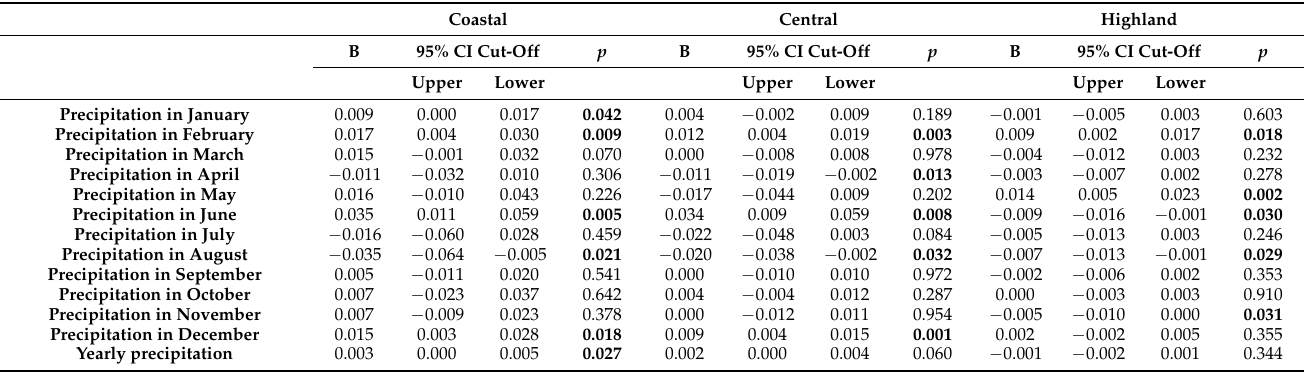
Table 3. Association between the number of cases of leishmaniosis and precipitation (mm) in coastal, central, and highland Montenegro.